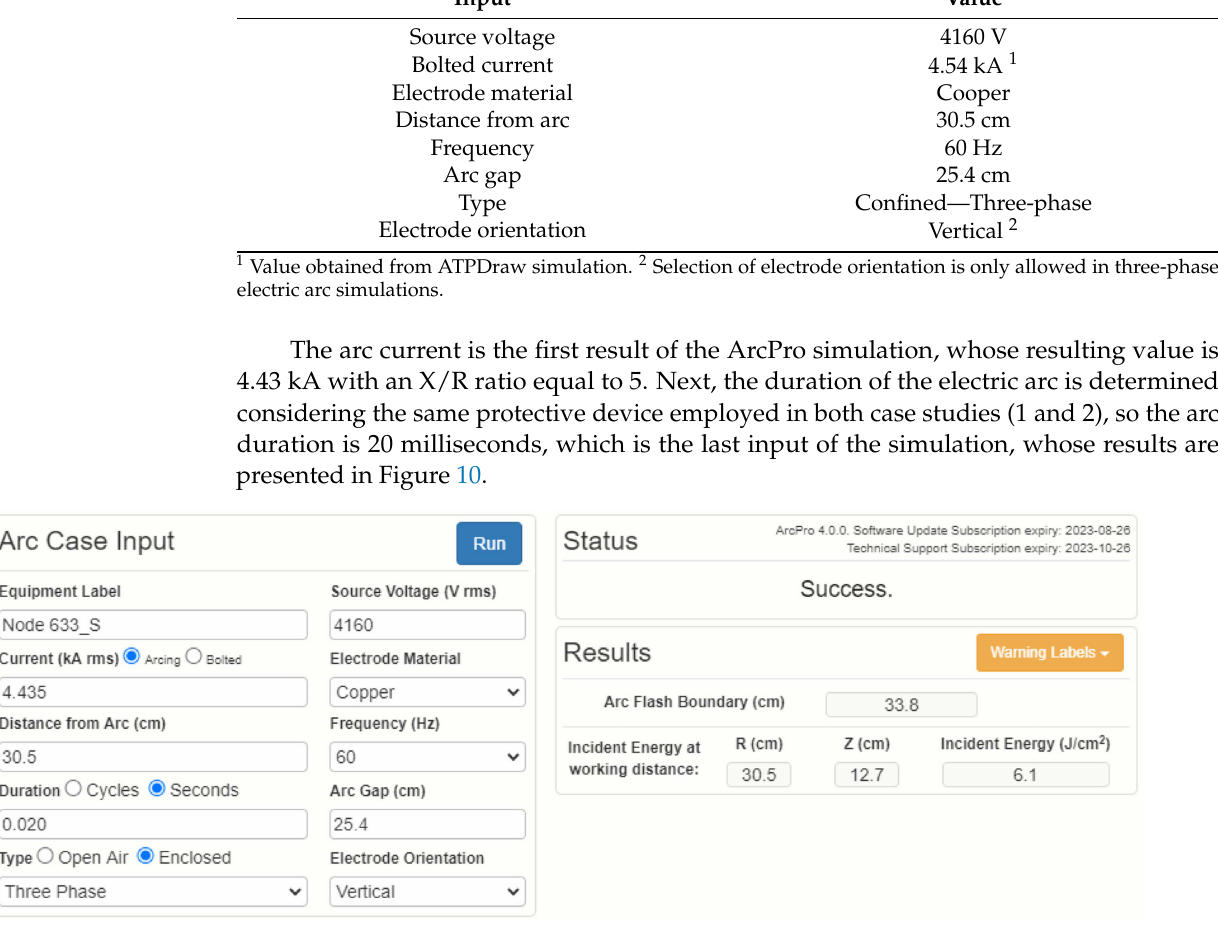
Figure 10. ArcPro simulation results—Case study